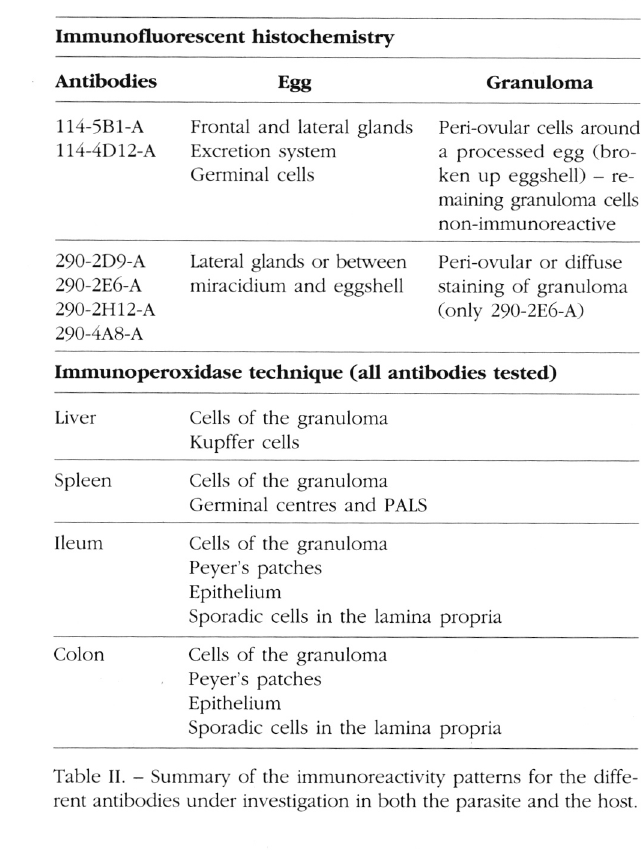
Table II. - Summary of the immunoreactivity patterns for the diffe­ rent antibodies under investigation in both the parasite and the host.